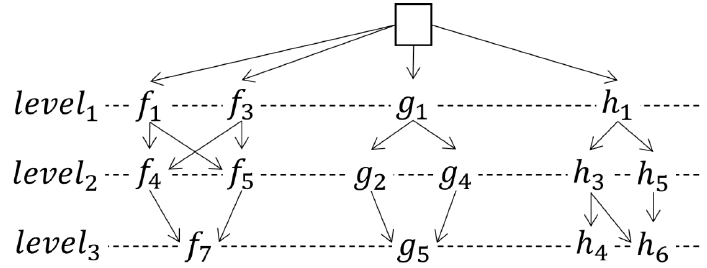
Figure 3. POI tree.